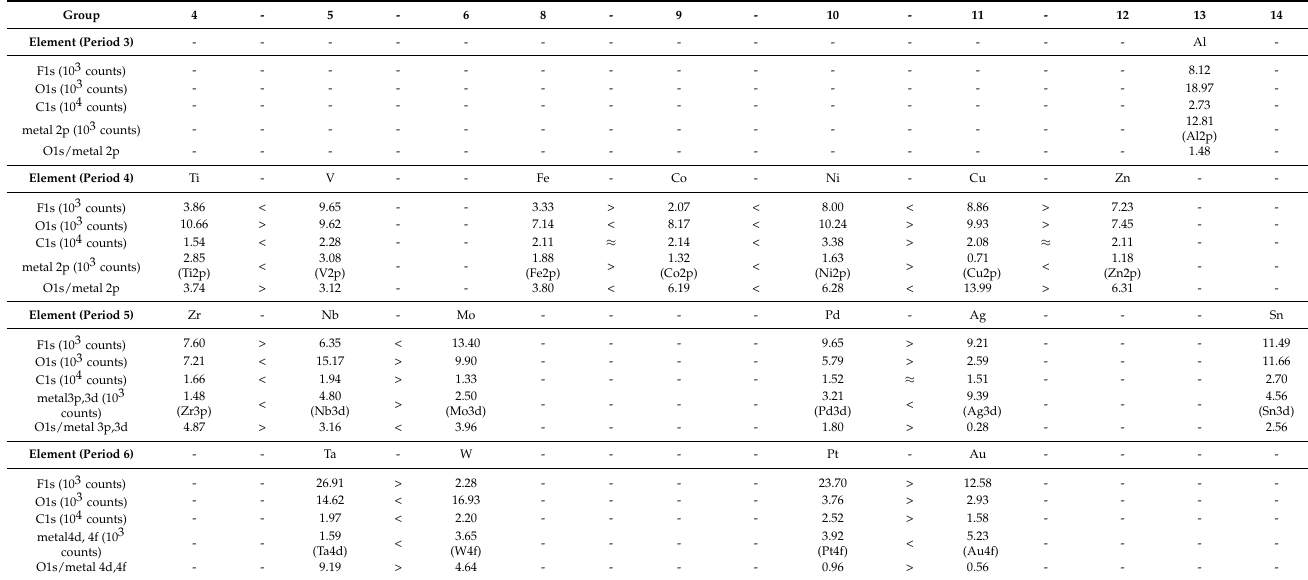
Table 4. The X-ray photoelectron spectroscopy (XPS) intensities 1 of F1s, O1s, C1s, and metal core spectra and the ratios of O1s/metal core after TriboEE measurement of the metals used. Group